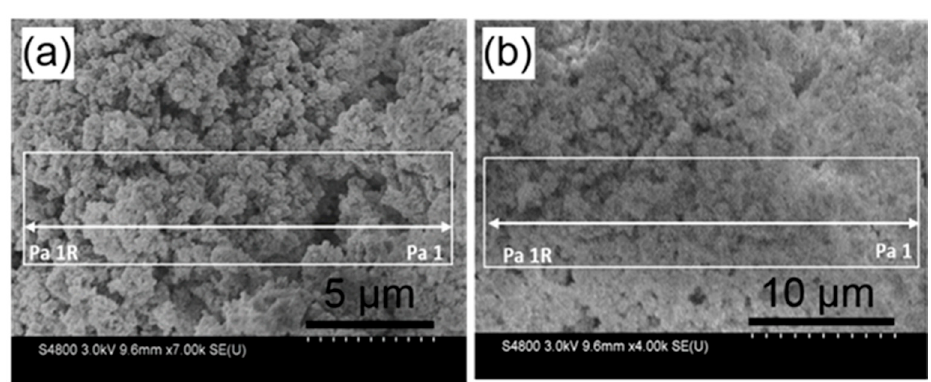
Figure 1. Field emission scanning electron microscopy (FESEM) images of ( a ) Bipy–PMO, and ( b )